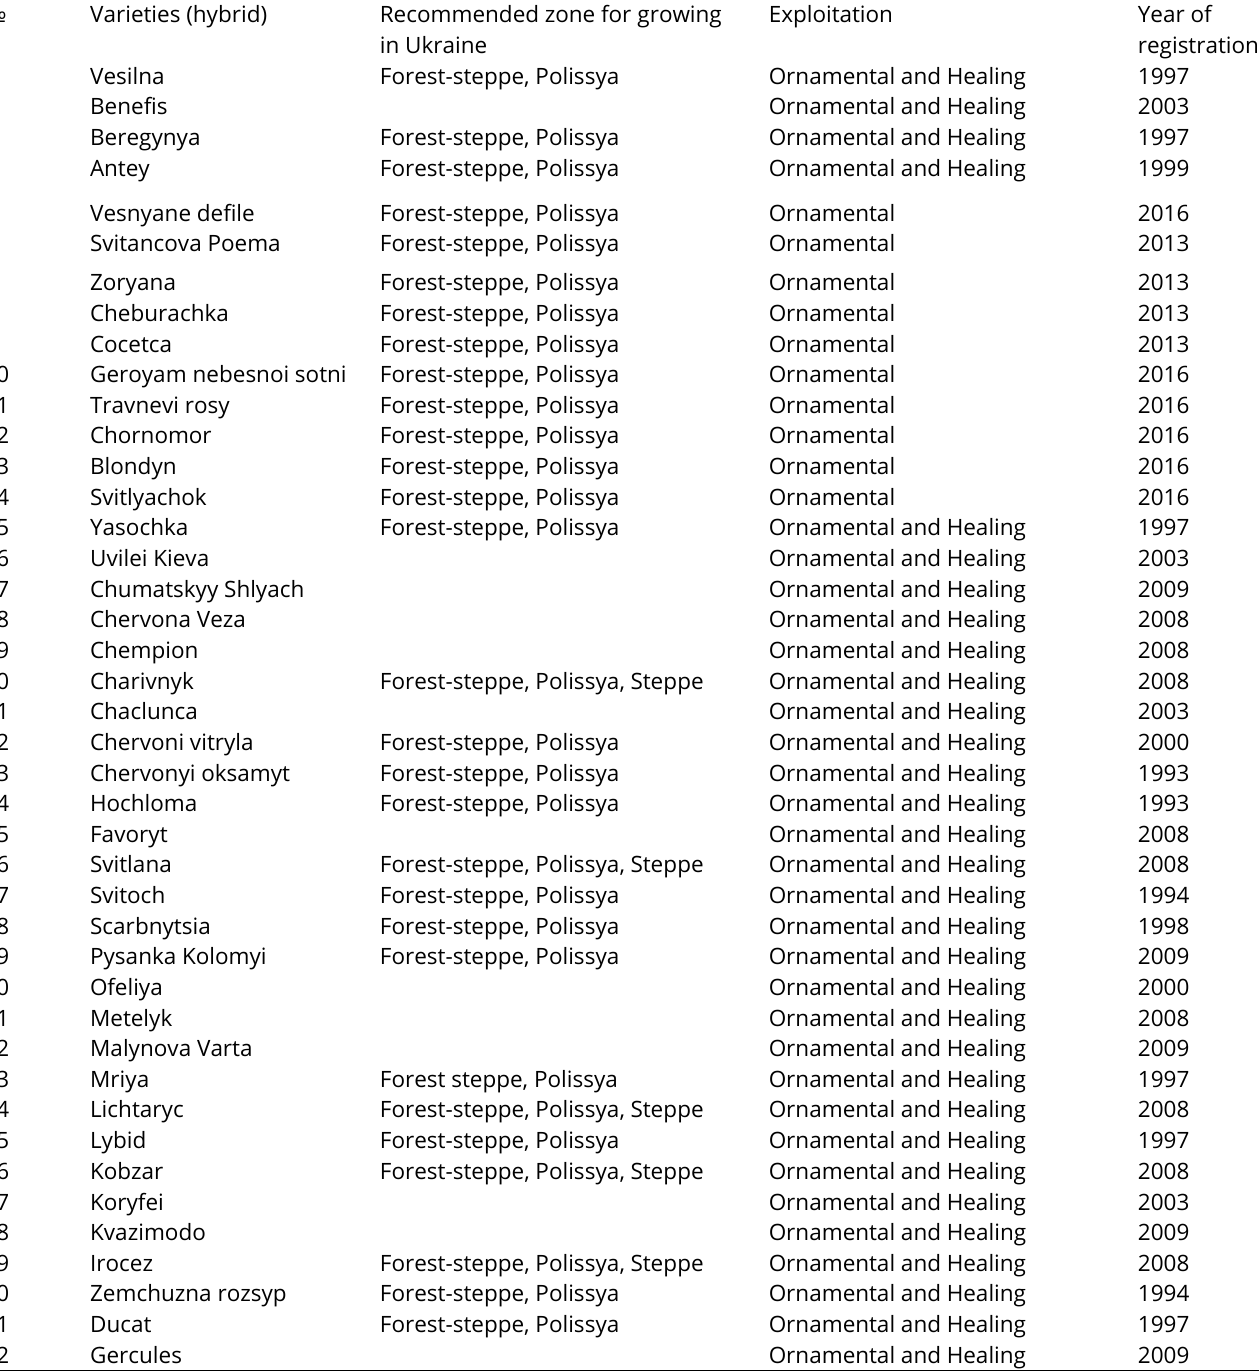
Svitlyachok (Table 1) (Horobets, 2017). Table 1. Varieties of Paeonia L., entered in the State Register of Plant Varieties, suitable for distribution in Ukraine